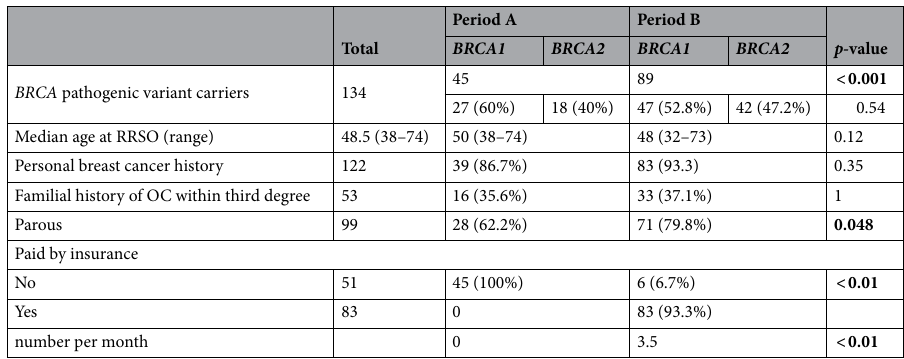
Table 1. Background of women with BRCA pathogenic variants. a Risk-reducing salpingo-oophorectomy. b Breast cancer. c Ovarian